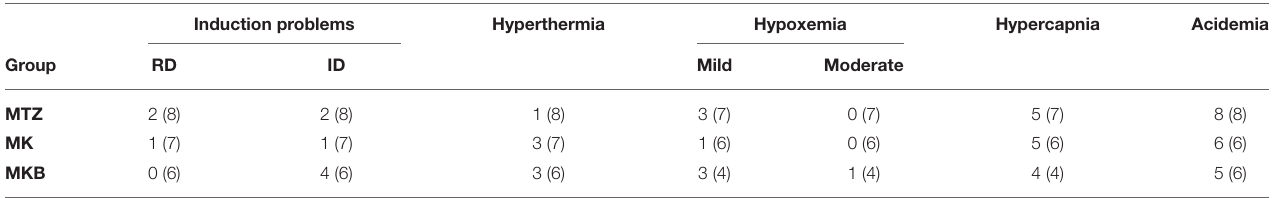
TABLE 3 | Complications during the anesthesia of cage-trapped wild boars anesthetized using medetomidine-tiletamine-zolazepam (MTZ; n = 8) or medetomidine-ketamine (MK; n = 7) or medetomidine-ketamine-butorphanol (MKB; n = 6).